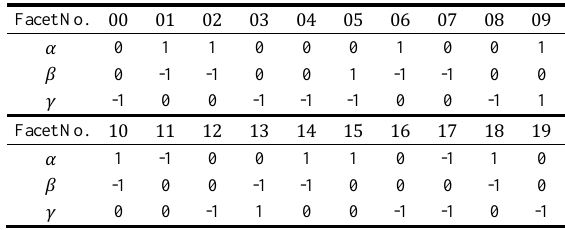
Table 5. 00 area was taken as the center for the icosahedron